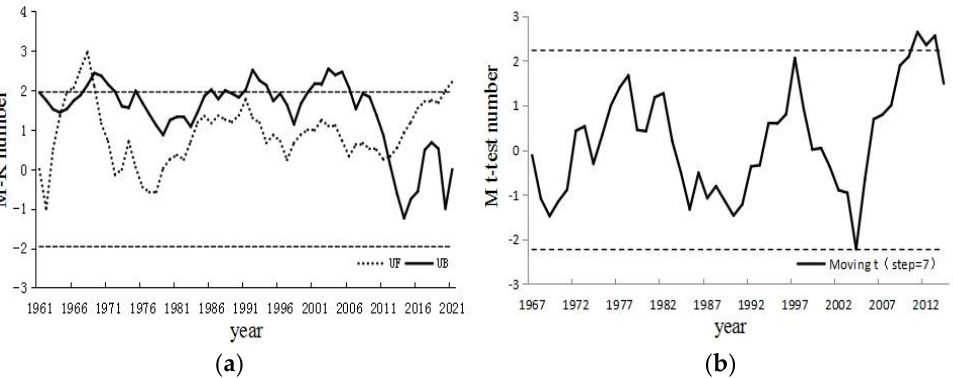
Figure 3. Mann – Kendall method ( a ) and moving t -test ( b ) analyses of rainstorms and floods in the summer half-year of 1961 – 2021 (horizontal lines are 95% reliability critical value).